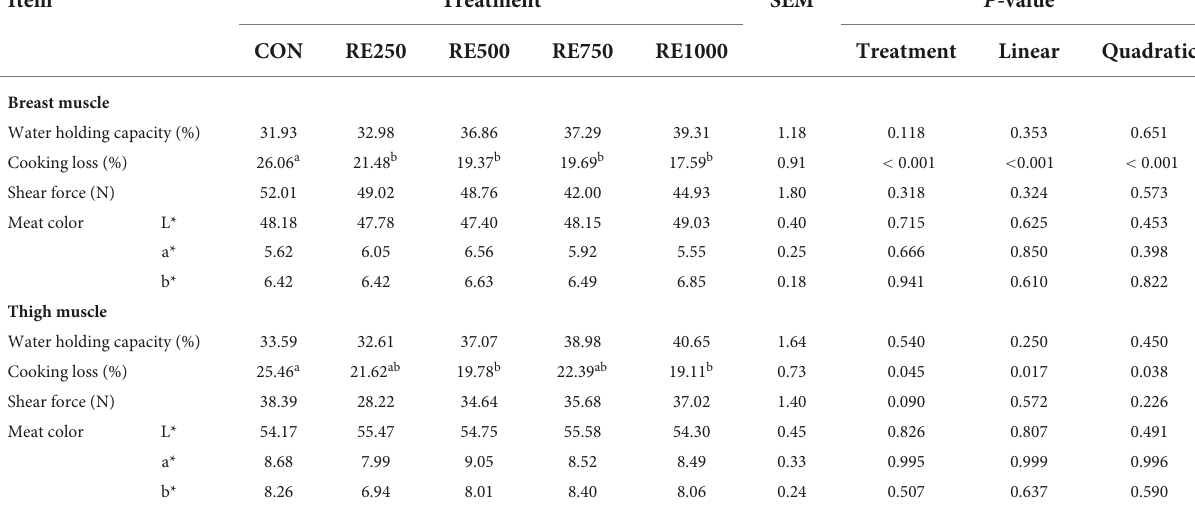
TABLE 3 Effects of rosemary extract on the meat quality of broilers 1